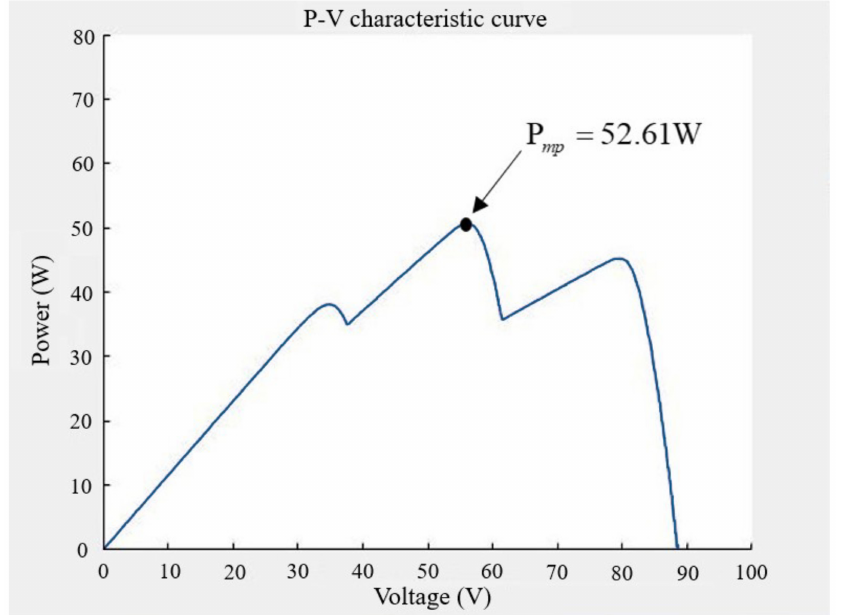
Figure 8. P–V characteristic curve simulation for Case 3.